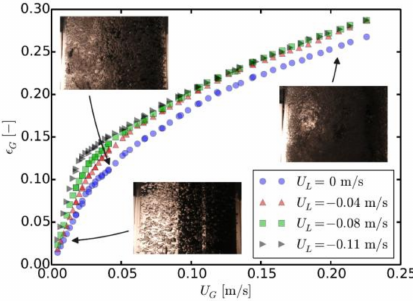
Figure 17. Pipe sparger in annular gap configuration—data from ref.